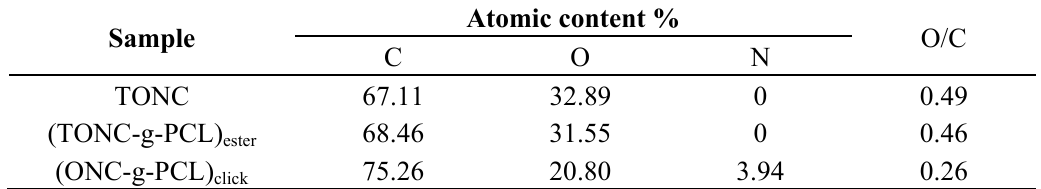
and (TONC-g-PCL) ester click